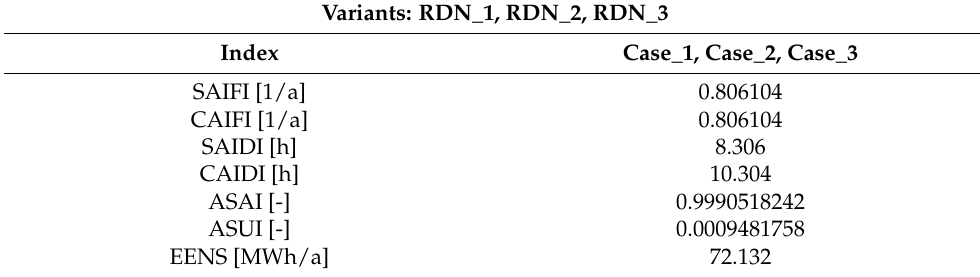
Table 10. Reliability system indices for RDN structure (Figure